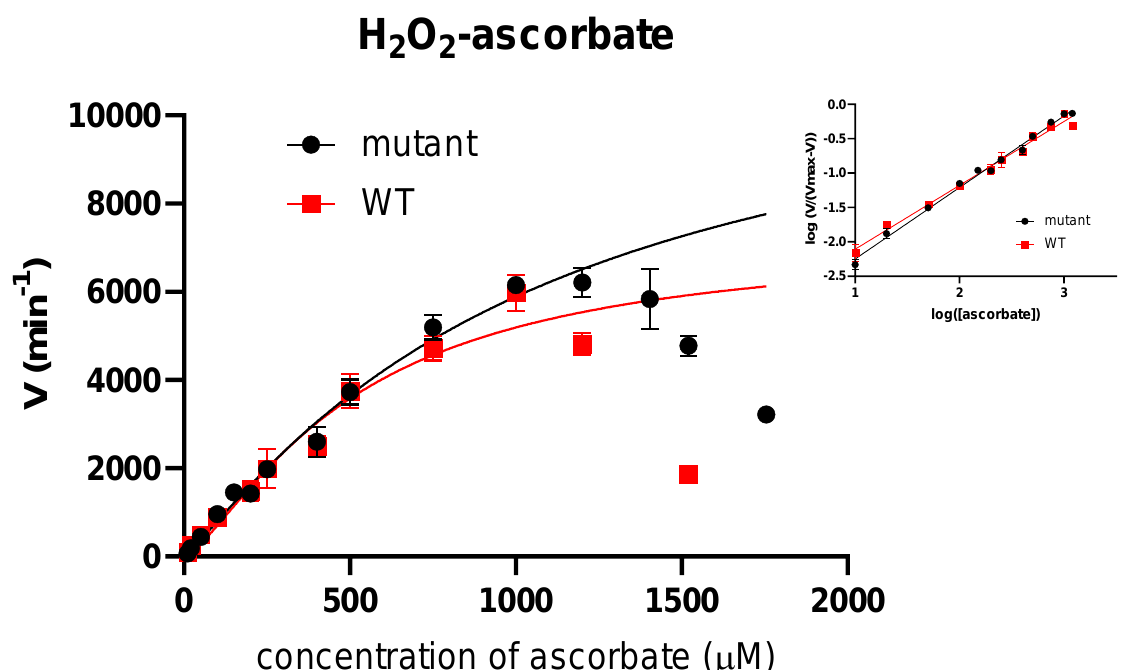
Figure 5. Kinetic assay of H 2 O 2 − dependent oxidation of ascorbate. Kinetic assay of PviAPX with ascorbate was performed with 1 mM H 2 O 2 in 50 mM potassium phosphate buffer, pH 7.0. The concentration of ascorbate varied from 10 µ M to 1800 µ M, and the final concentration of PviAPX was 15 nM. The fitting was conducted with the ascorbate concentration ranging from 0 to 1200 µ M. All the error bars indicate the standard deviation ( n = 3). The insert shows the Hill plot fitted with linear regression.